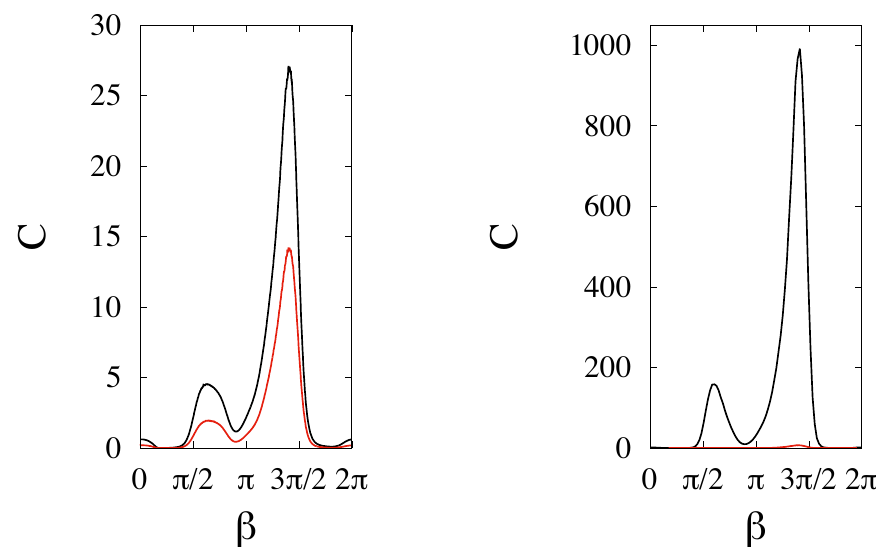
Figure 13. One-dimensional profiles of the cumulative particle concentration along the same selected circumferences embedded in the effective obstacle surface as those depicted in Figure 12 for r p = 0.05 and Pe ref = 10 3 ( left ) and Pe ref = 3.5 × 10 3 ( right